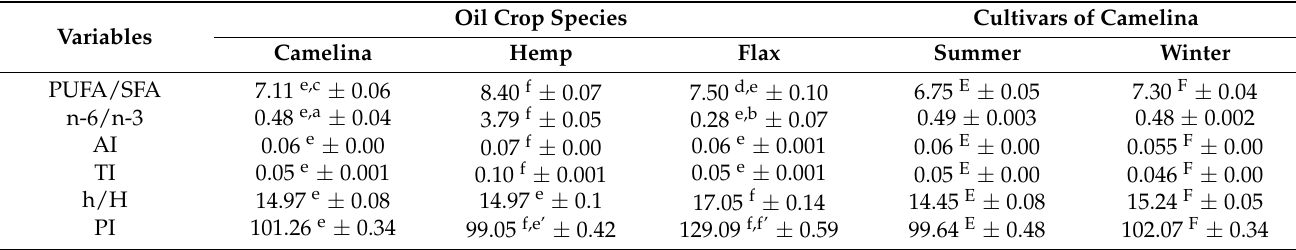
The differences between the means of crop species and between camelina cultivars in the rows with different superscripts differ at a,b p < 0.05; c,d p < 0.01; e,f;e’,f’ and E,F p < 0.001. PUFA/SFA = ratio of PUFA to SFA, n-6/n-3 = ratio of n-6 PUFA to n-3 PUFA, AI = atherogenic index, TI = thrombogenic index, h/H = hypocholesterolemic/hypercholesterolemic ratio, PI = peroxidizability